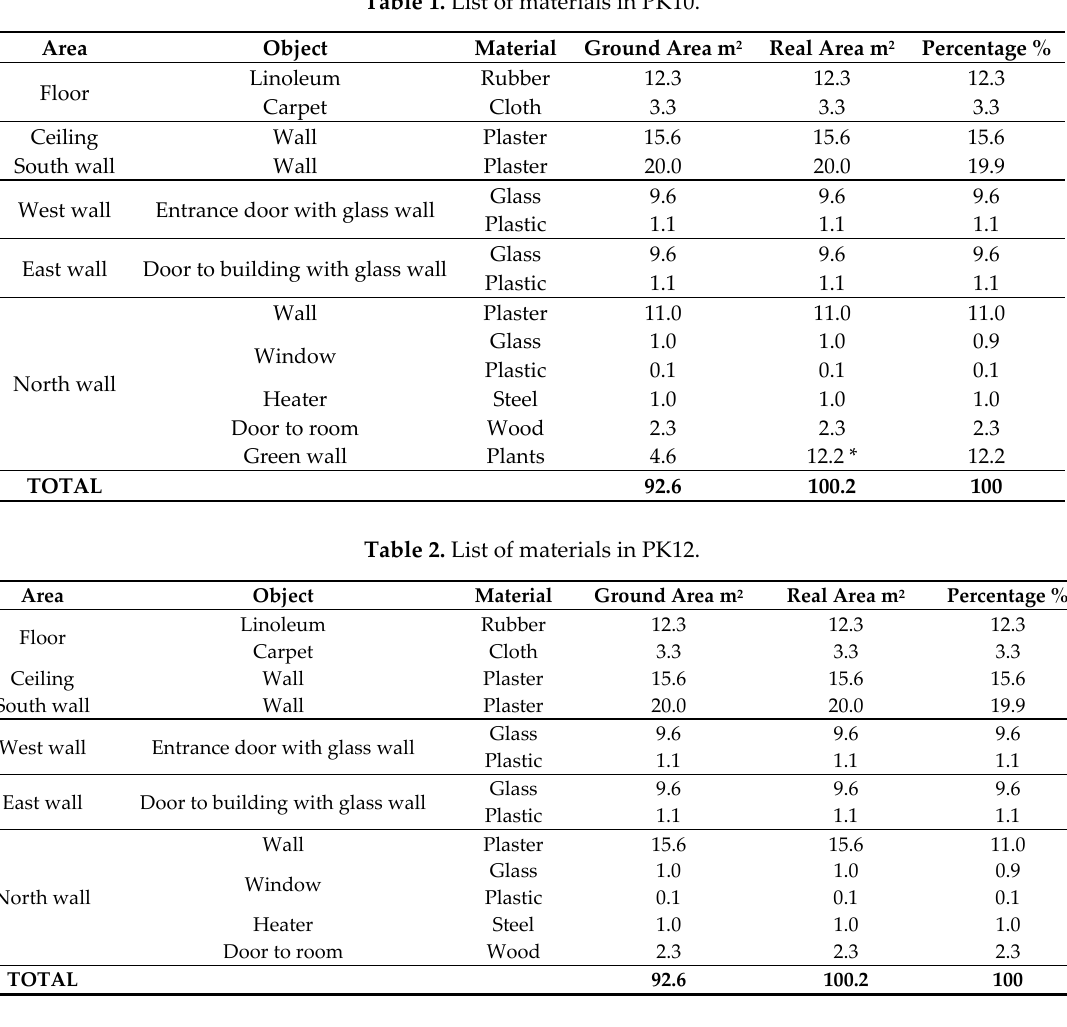
Table 1. List of materials in PK10.